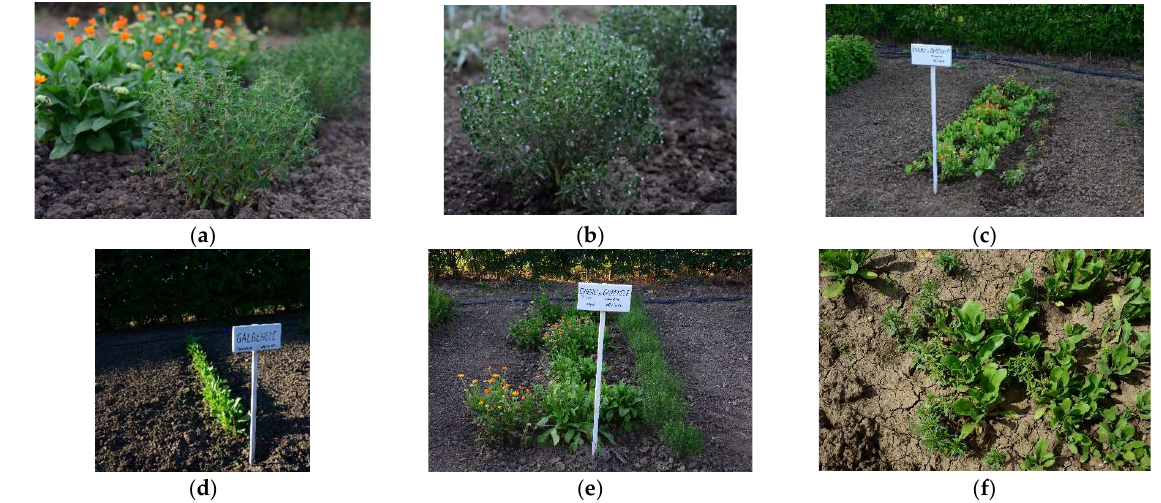
Figure 5. The horizontal evolution of Thymus vulgaris L. and Calendula officinalis L. phytosociological